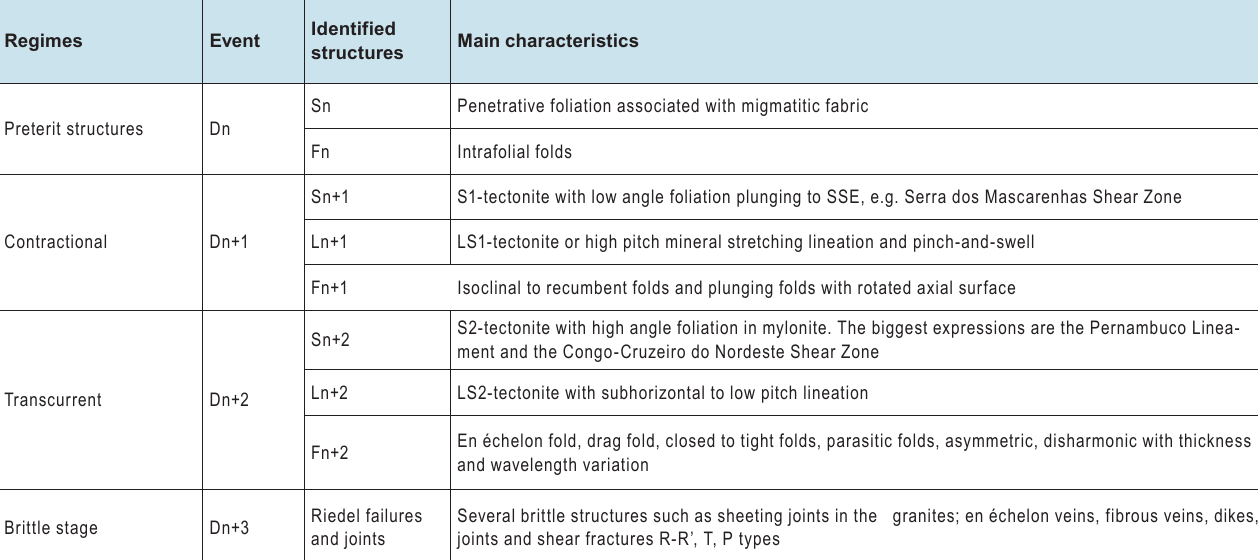
TABLE 1 – Synthesis of the main deformational phases of the